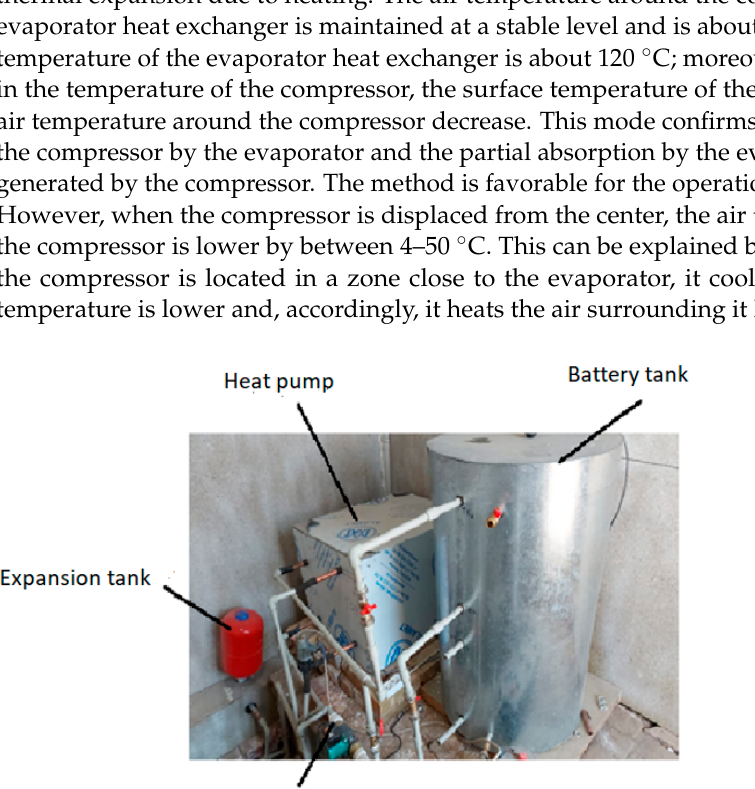
Figure 3. Test bench.